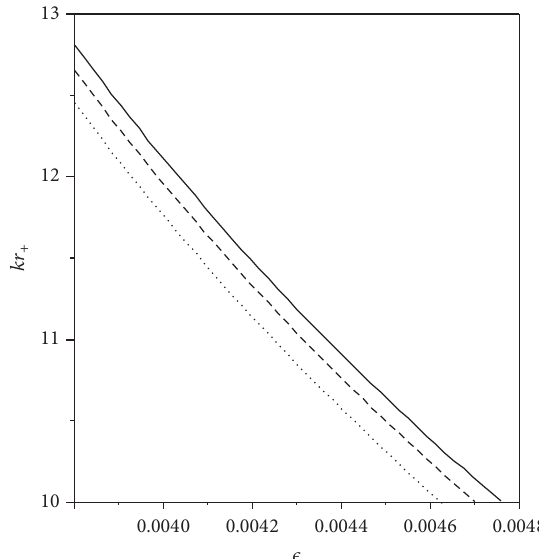
Figure 1: The variation of 𝑘𝑟 + defined by (15) and (19) versus the parameter 𝜖 . The values of the parameters are V 𝑠 = 1 and V 𝑝 = 1.2 . The solid curve corresponds to limit of infinite coupling ( 𝑡 = 𝑞 = 0.0 ). For the dashed curve the values of these parameters are 𝑡 = 𝑞 = 0.1 and for the dotted curve are 𝑡 = 𝑞 = 0.2 .